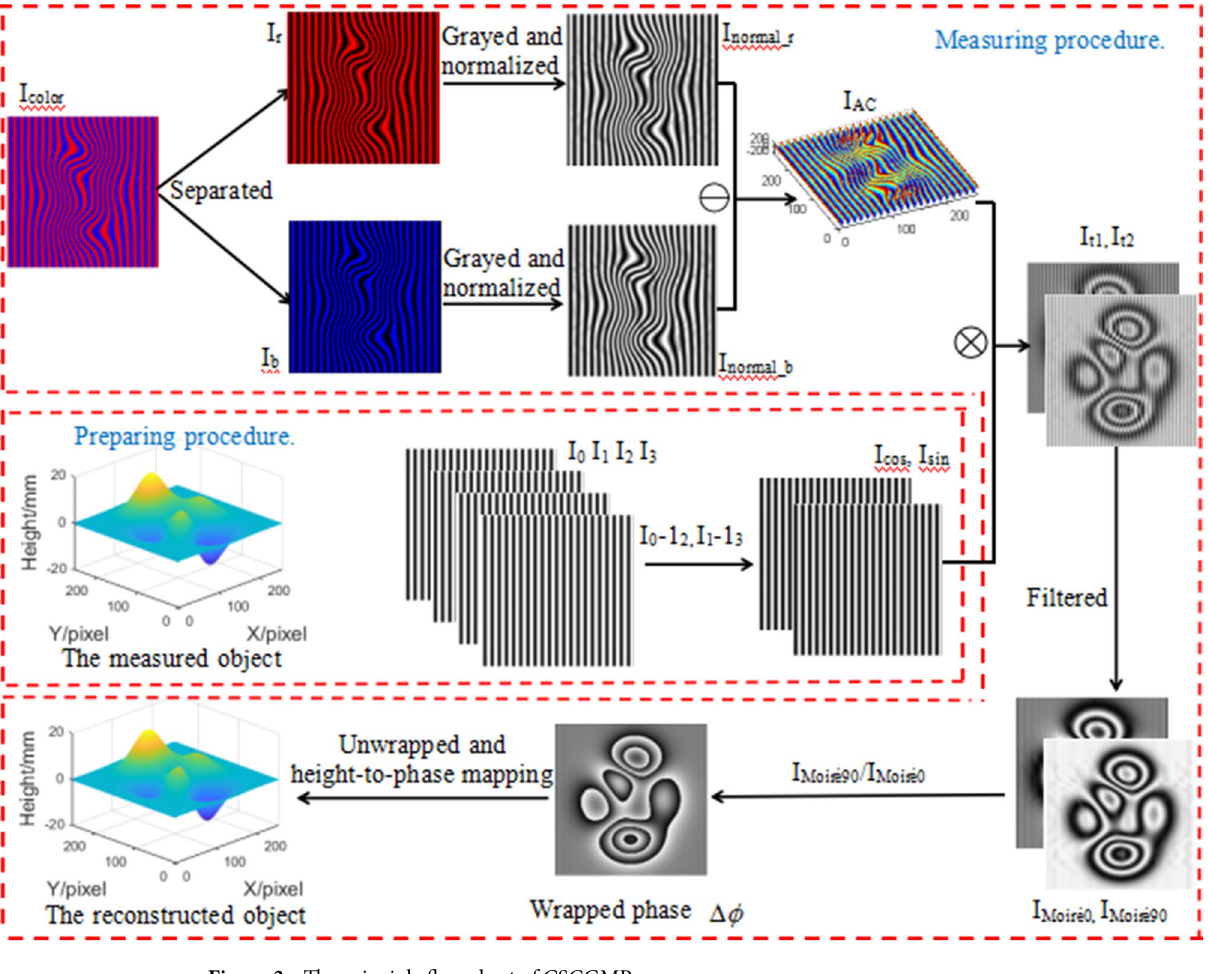
Figure 3. The principle flow chart of